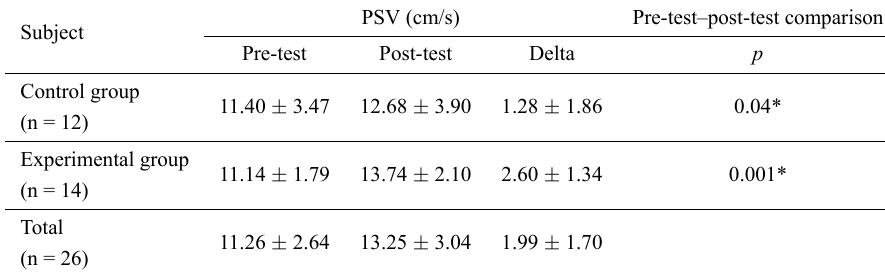
Table 5. Comparison of PSV values.